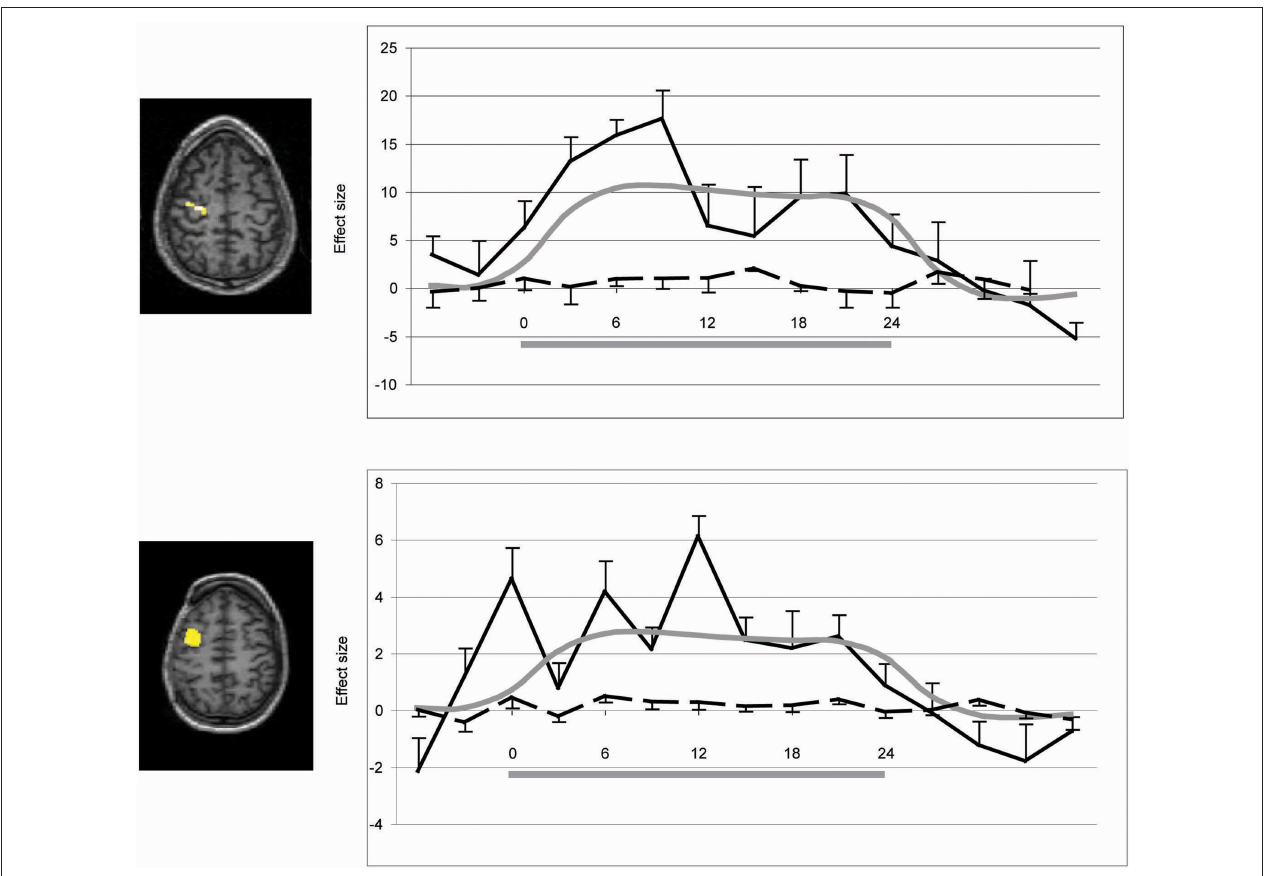
Figure 5 | Time course of rOi activity for left premotor cortex for VS1 and VS2. The gray horizontal bar shows when the commands were delivered. The solid black line corresponds to the “right hand vs. left hand” contrast, whereas the dashed line corresponds to the “left hand vs. right hand “contrast. Standard errors are shown for each contrast.” The gray line corresponds to the model’s